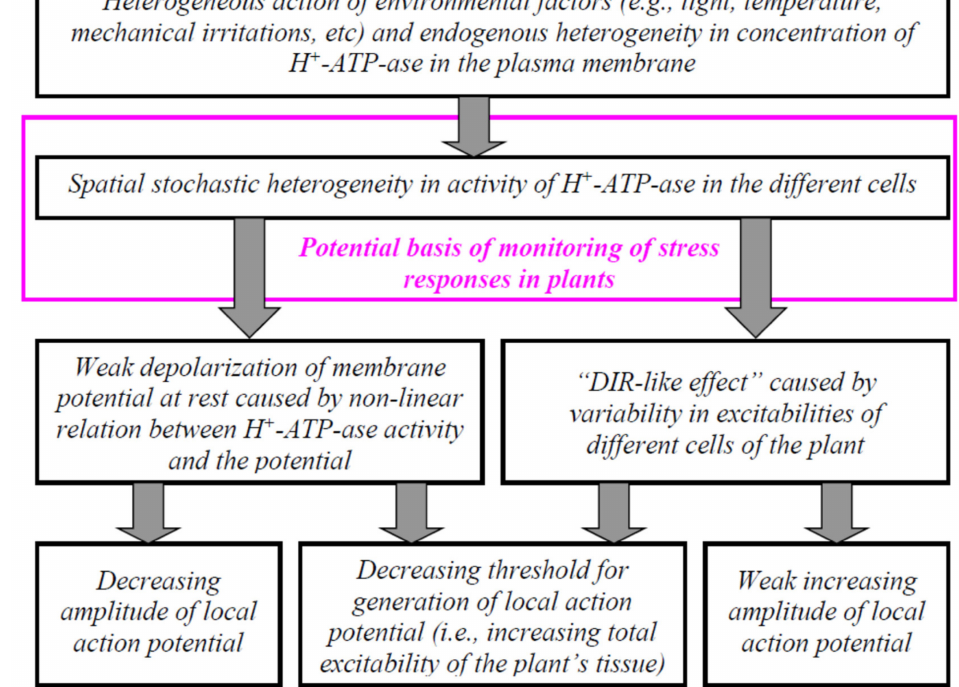
Figure 10. Hypothetical scheme of influencing stochastic spatial heterogeneity in the activity of H + -ATP-ase in different cells of the plant tissue on amplitudes and thresholds of local action potential in the zone of irritation. The scheme is based on our theoretical analysis of influencing the spatial heterogeneity on parameters of cooling-induced local action potentials. DIR is the diversity-induced